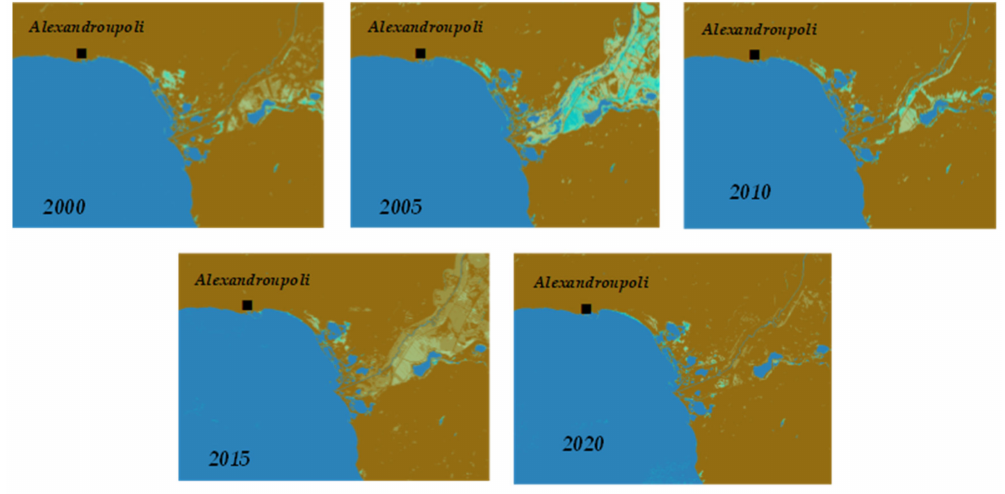
Figure 13. Generated yearly Average maps (water probability is shown as shades of